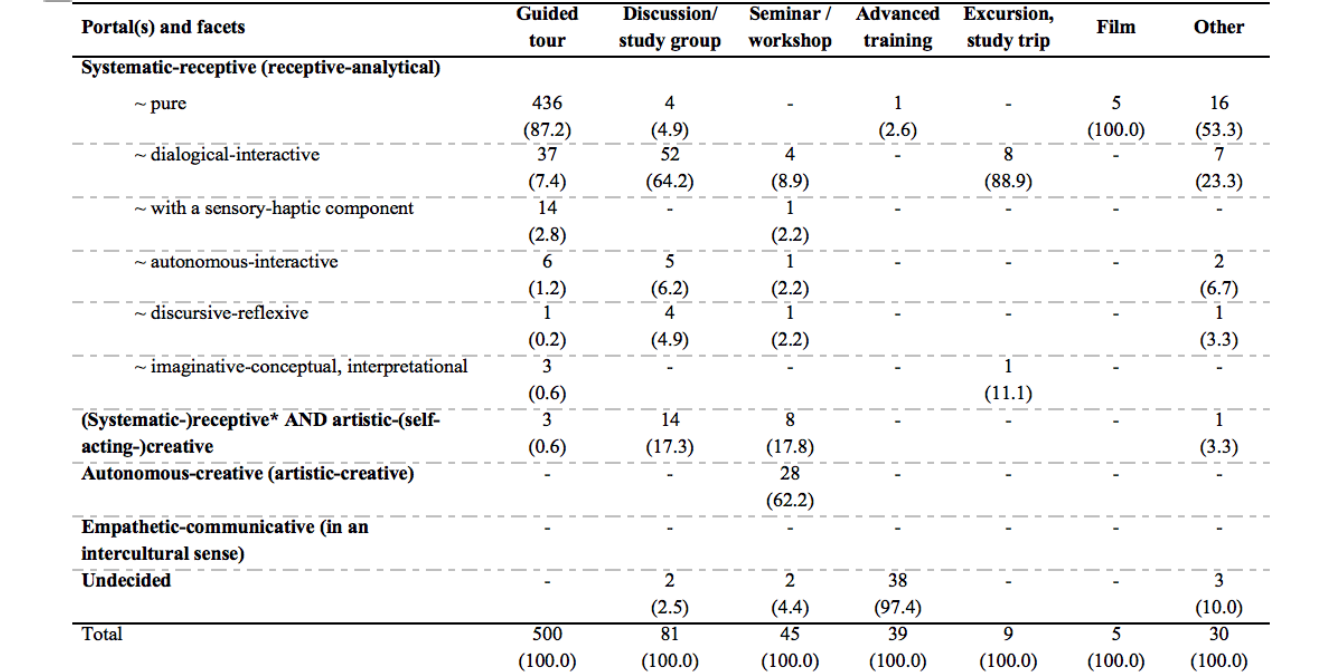
Table 3. Frequency of the portals and their newly defined facets with regard to